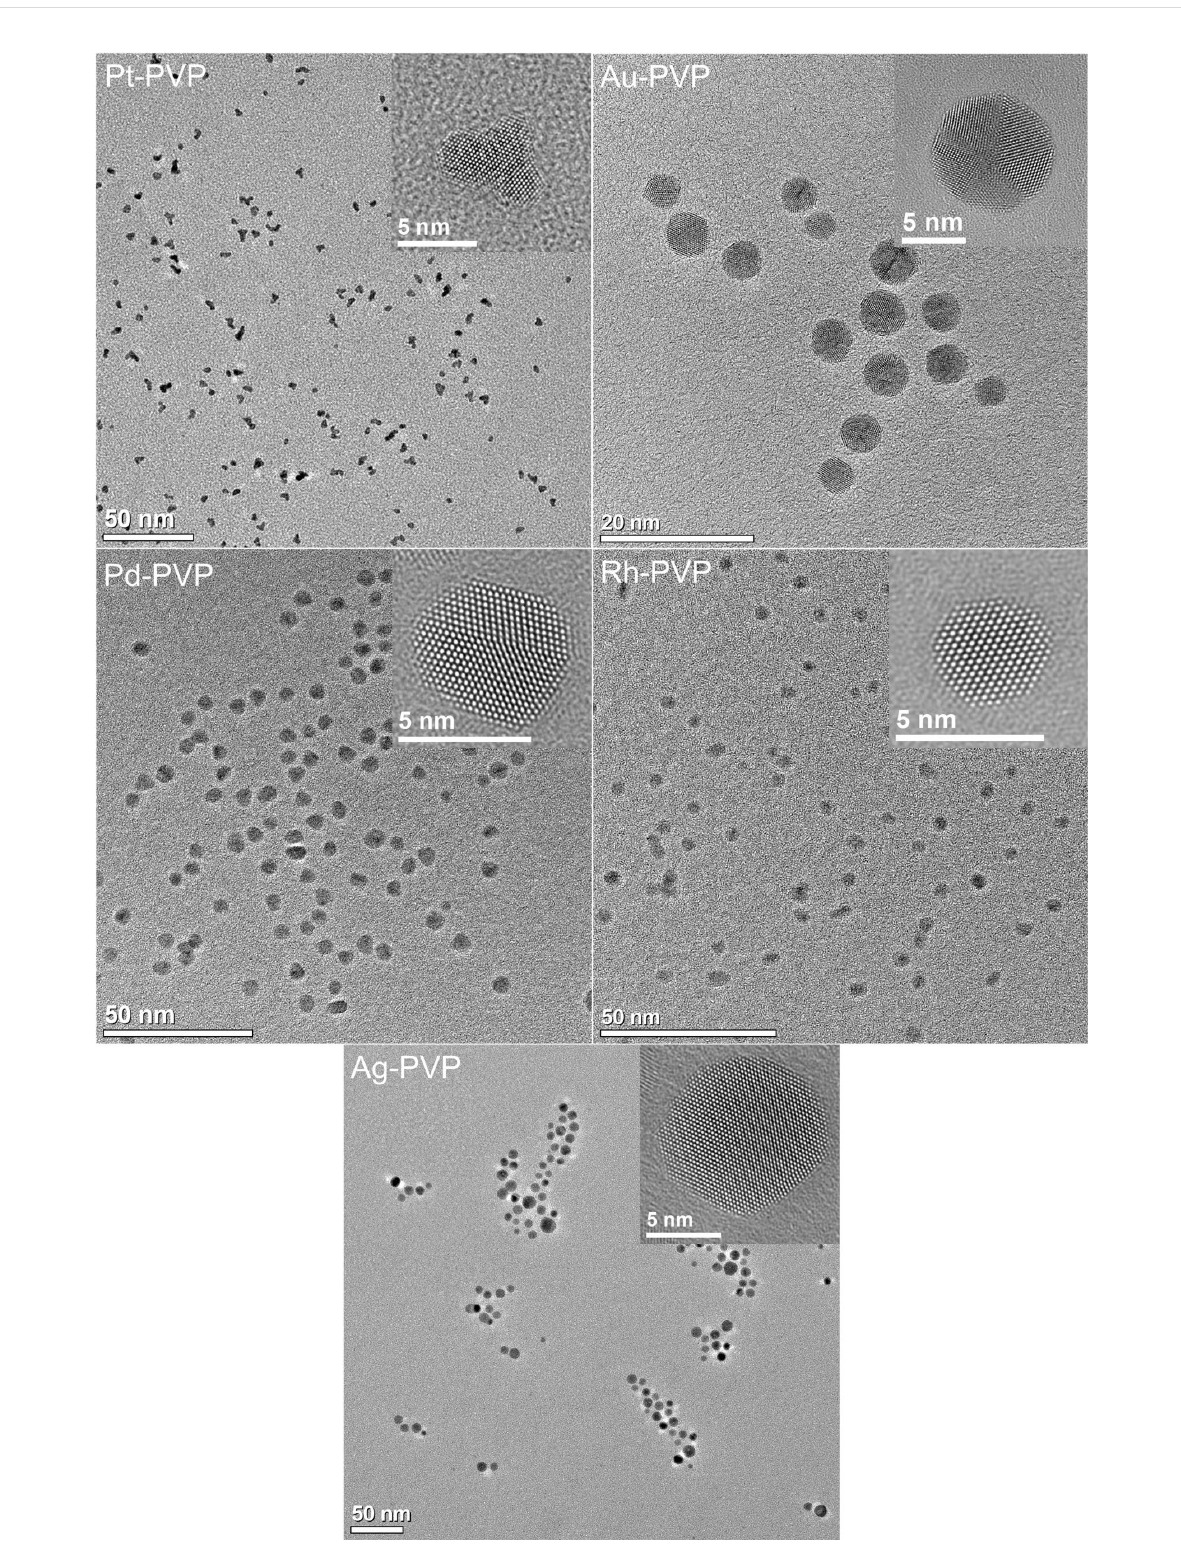
Figure 3: Representative high-resolution TEM images of PVP-stabilized noble metal nanoparticles (Rh, Pd, Pt, Ag, Au). In each upper right corner, a typical nanoparticle is shown in higher